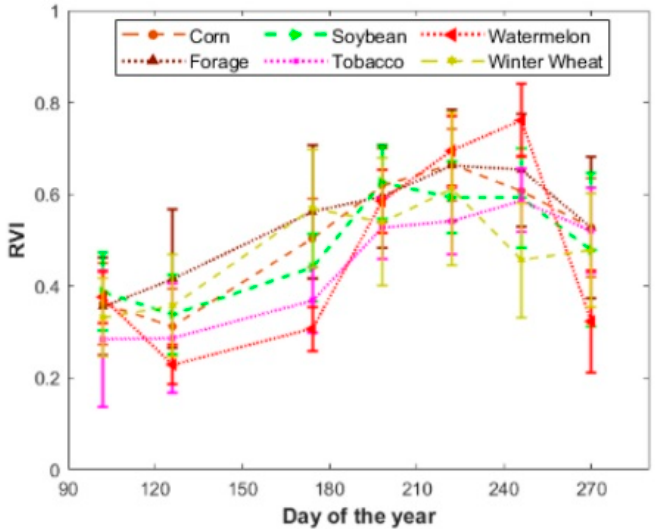
Figure 8. Temporal evolutions in RVI. Note error bars denote standard